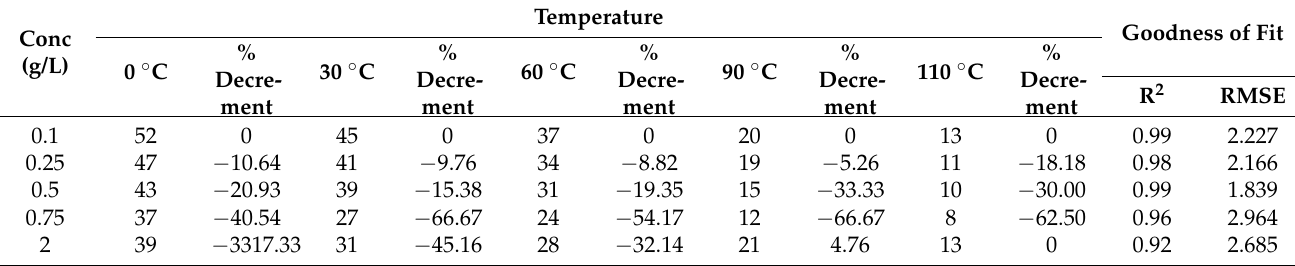
Table 4. Variation of kinematic viscosity (cSt) of MRO under the influence of Al 2 O 3 concentration and Temperature with 95% confidence.